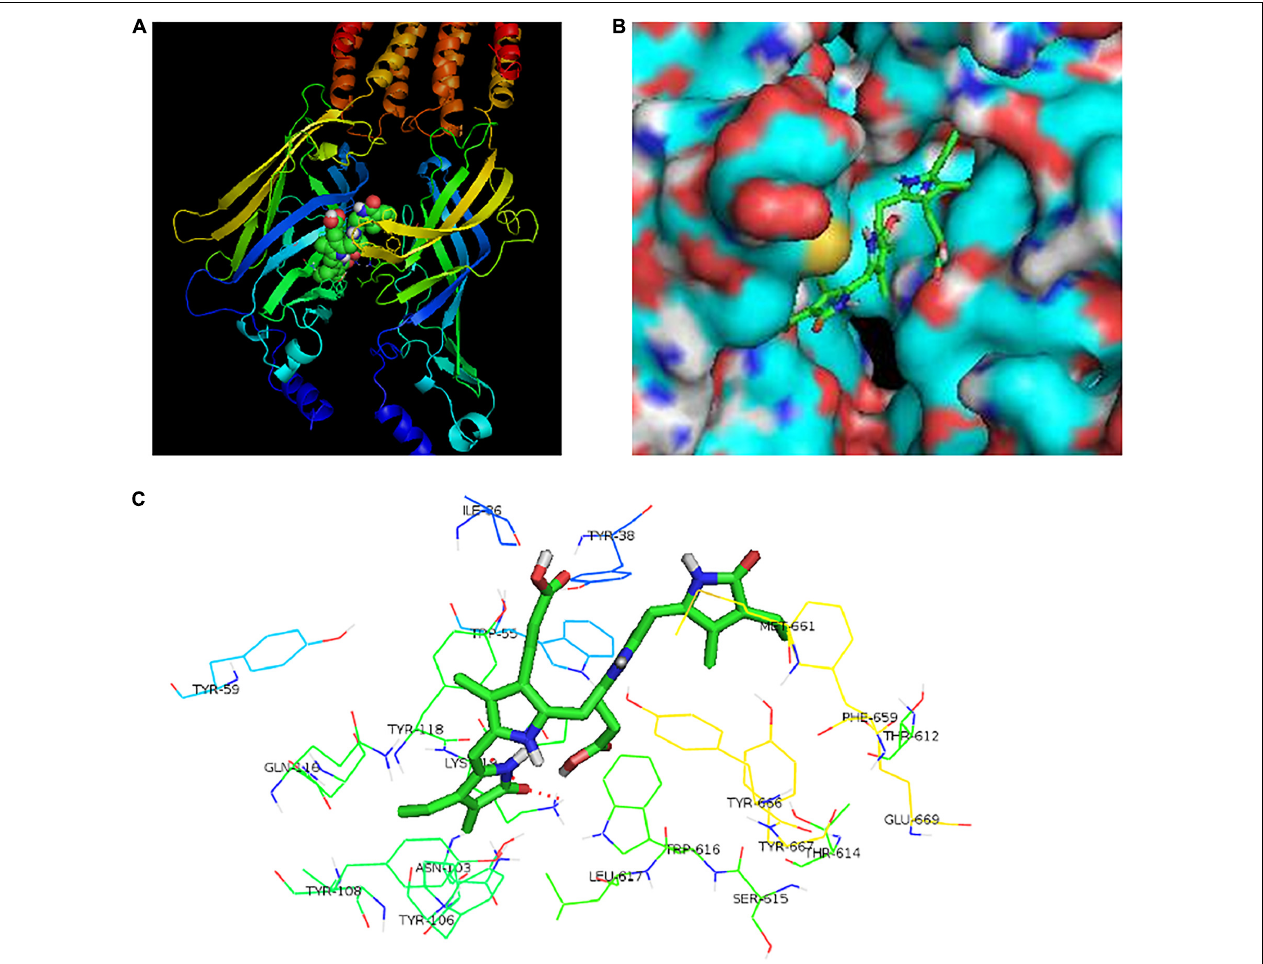
FIGURE 4 | The potential binding sites of bilirubin and the 5-HT 3 A receptor. (A) Bilirubin combined with the spatial structure of 5-HT 3 A receptor. (B) Bilirubin entered the hydrophobic gap formed by 5-HT 3 A receptor subunits with benign complementarity. (C) Through calculation, bilirubin was able to bond to multiple amino acid residues of the 5-HT 3 A receptor with hydrogen bond formation. The binding sites of bilirubin and the 5-HT 3 A receptor were MET661, LYS 119, TYR118, ILE86, TYR38, and ASN103. Hydrogen bonds were found between TYR38, LYS119 and two carbonyls of bilirubin.